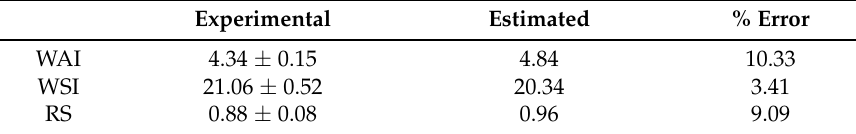
Table 6. Experimental and predicted values of the responses